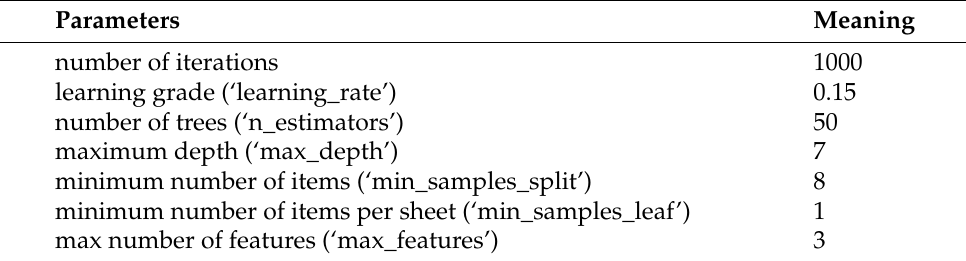
Table 4. Hyperparameters of the RF classifier and their values used for classification.